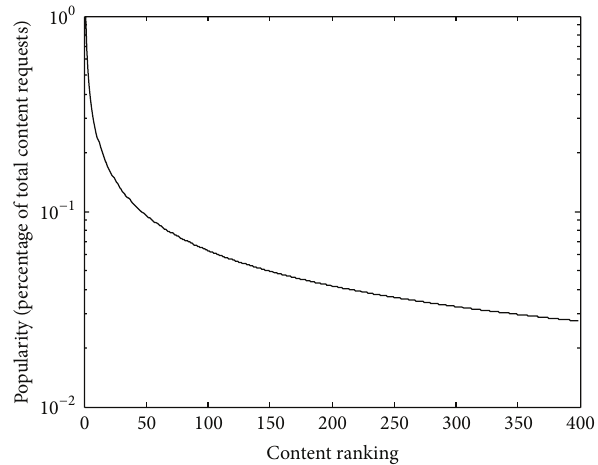
Figure 3: Content popularity in a Zipf-like